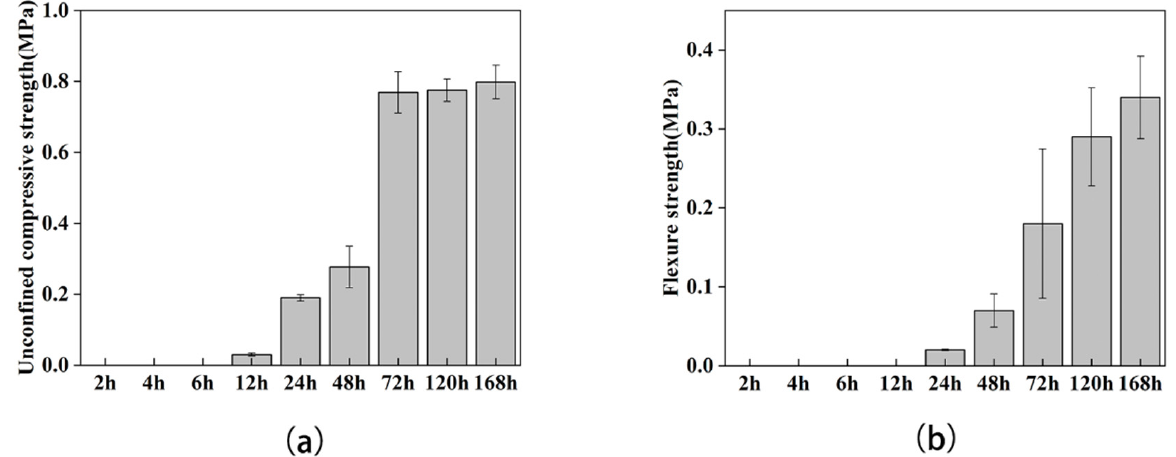
Figure 5. Mechanical performances of sand columns at different time point. ( a ) Unconfined com- pressive strength of sand columns; ( b ) flexure of sand